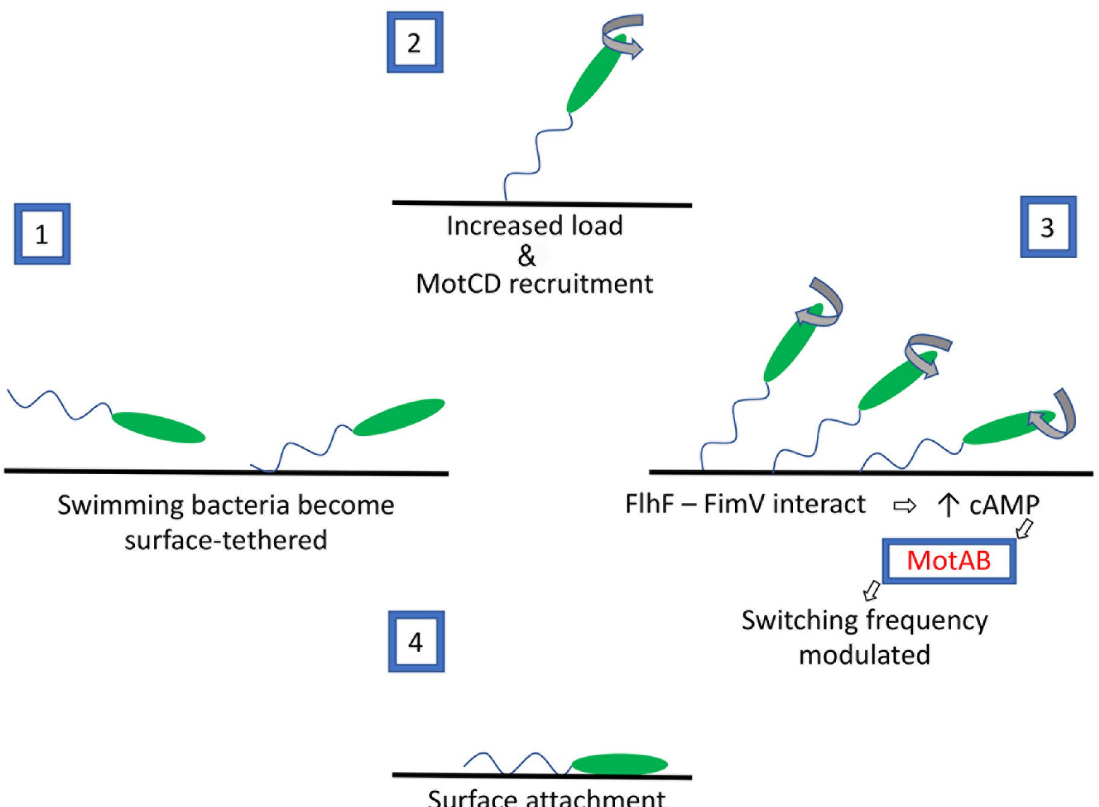
Fig 11. A model for modulating flagellar rotation in response to surface tethering. 1) Swimming bacteria can make contact with a surface via their flagellum. 2) Continued flagellar rotation of these attached bacteria increases the load on the flagellar motor. MotCD must be present for tethered bacteria to rotate, suggesting that it is recruited to the motor in this setting. 3) FlhF interacts with FimV in tethered bacteria, which we propose leads to an increase in intracellular cAMP. cAMP is a sufficient signal to modulate flagellar switching frequency if MotAB is present in the cell. 4) Horizontal attachment of the cell body to a surface follows flagellar surface-tethering if FlhF and FimV are present in